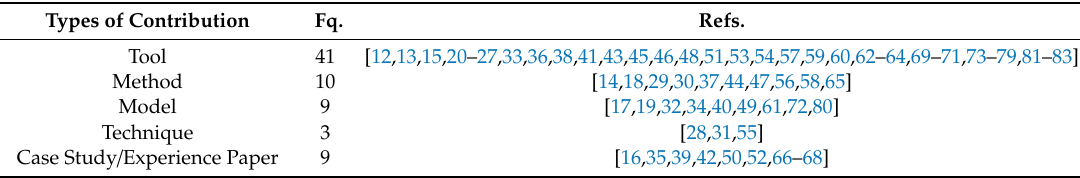
Table 8. Types of research